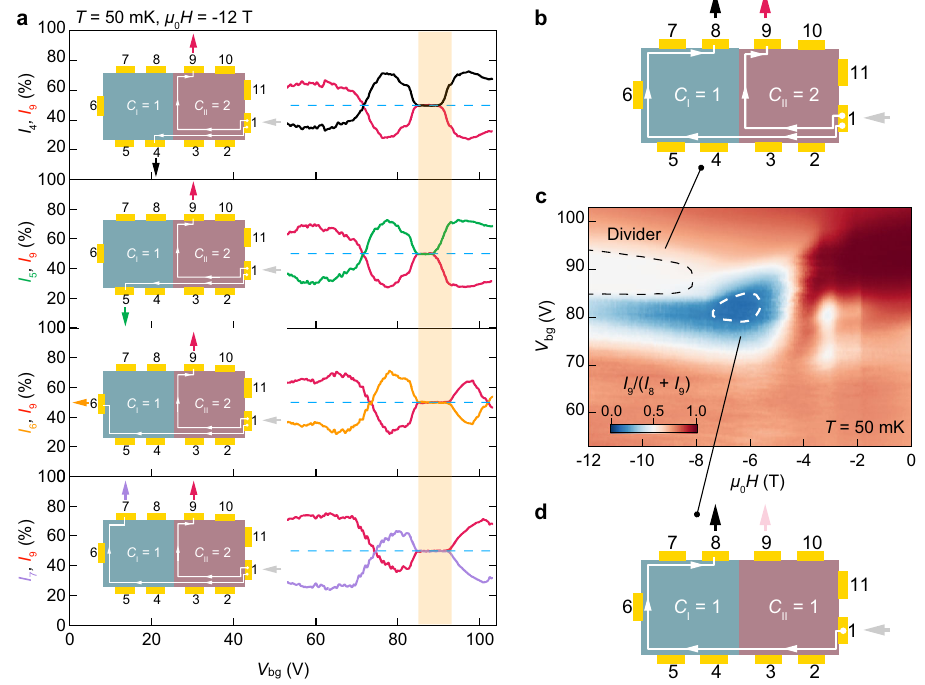
Fig. 3 | Characterization and control of topological circuit. a Operation of the dissipationless chiral edge current divider with the bias applied at contact 1 and various drain con fi gurations at μ 0 H = − 12 T. Insets are the current fl ow diagrams. The semi-transparent yellow bar highlights the gate voltage range for a functional currentdivider,wheretheinjectedcurrentsplitsequallyattheChernjunction.The nearly identical outputs with different drain con fi gurations demonstrate the dis-